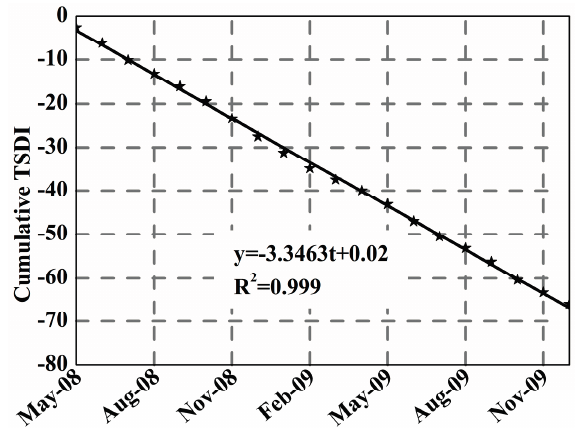
Figure 10. Cumulative total storage deficit index (TSDI) for the arid land of northwestern China.